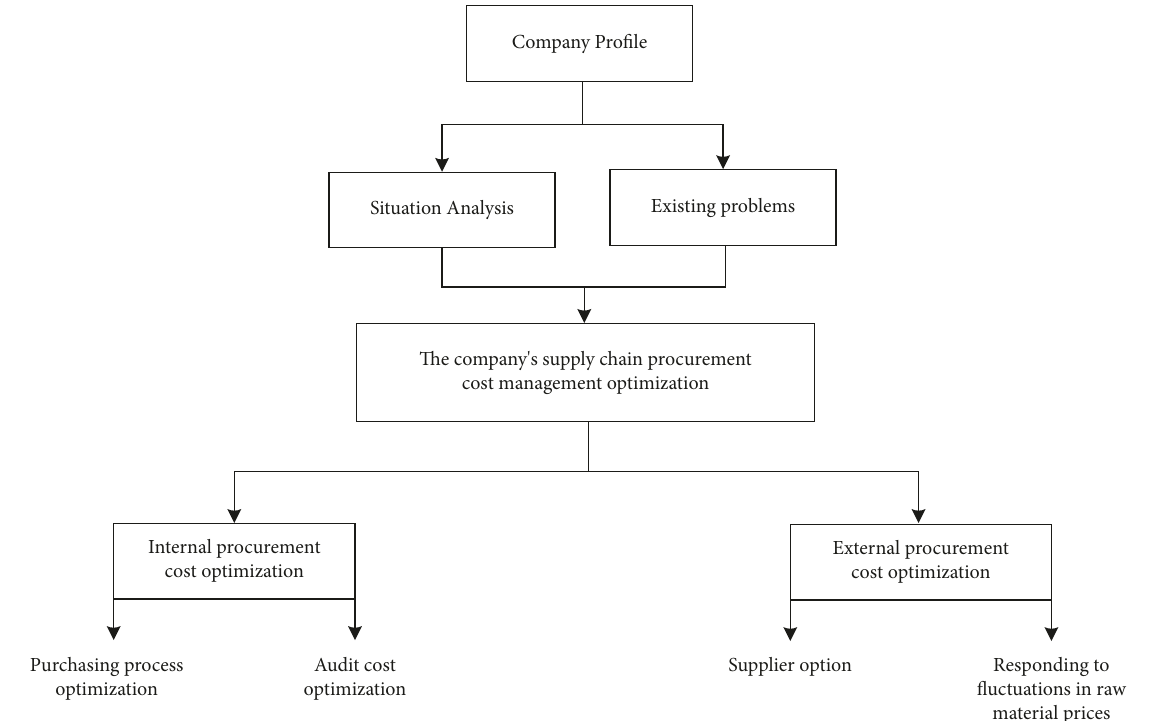
Figure 4: The specific steps of purchasing cost control optimization.